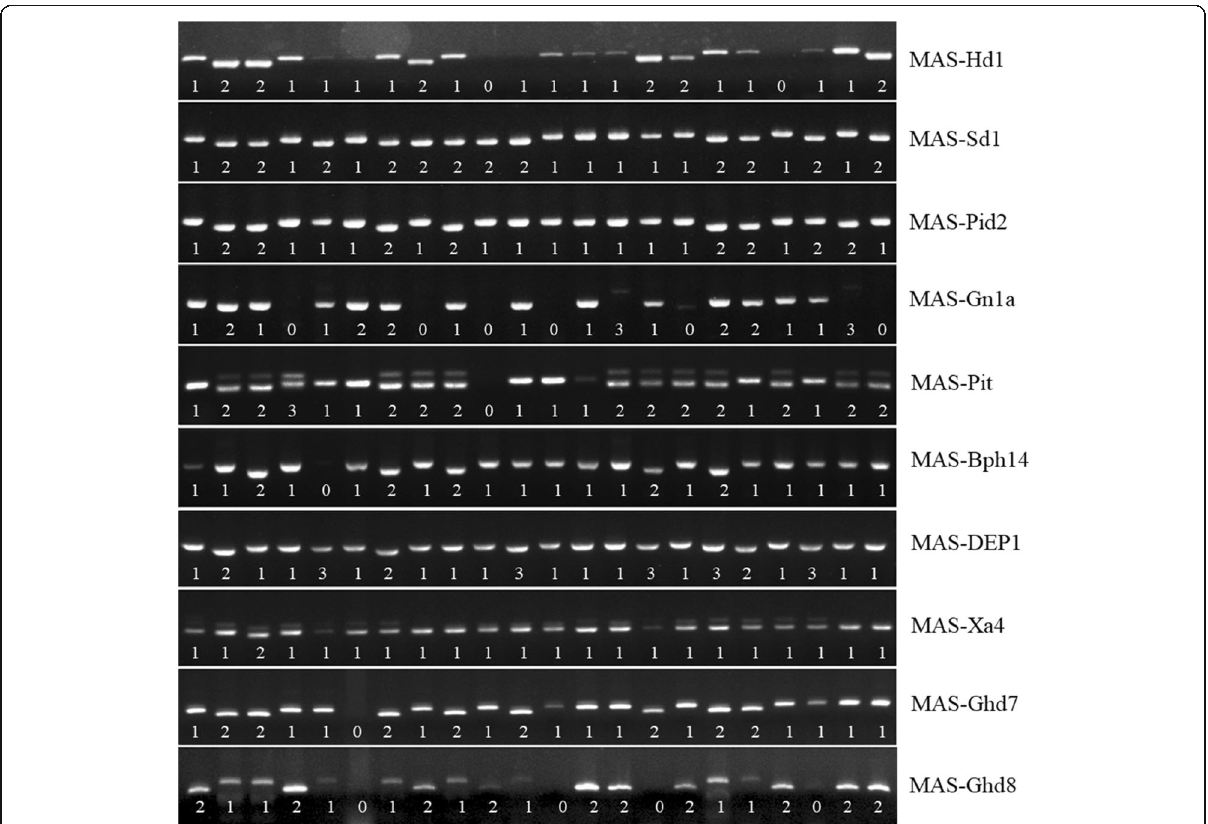
Fig. 5 Genotypes of the 22 cultivars at 10 breeding marker loci. The samples from left to right are from the 22 rice varieties as follows: Zhonghua11, ZS97, MH63, Xizang2, N22, Nipponbare, 9311, 02428, Teqing, Taichung65, Chuan7, Haobuka, Wuyugeng, Gangye, H360,